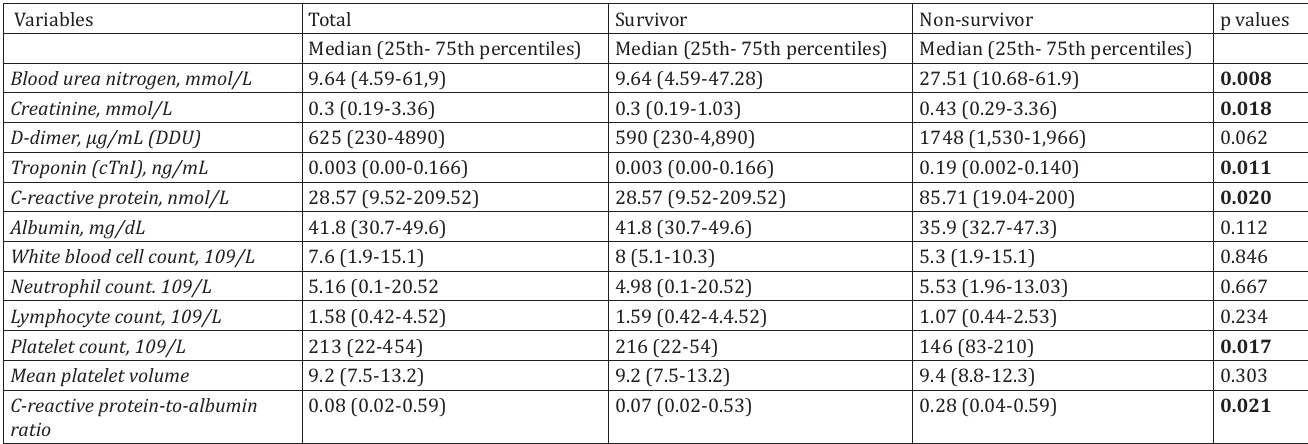
The data is presented as number and percent, median and 25th to 75th Laboratory parameters of the enrolled patients and comparison of these parameters between the survivor and non-survivor groups